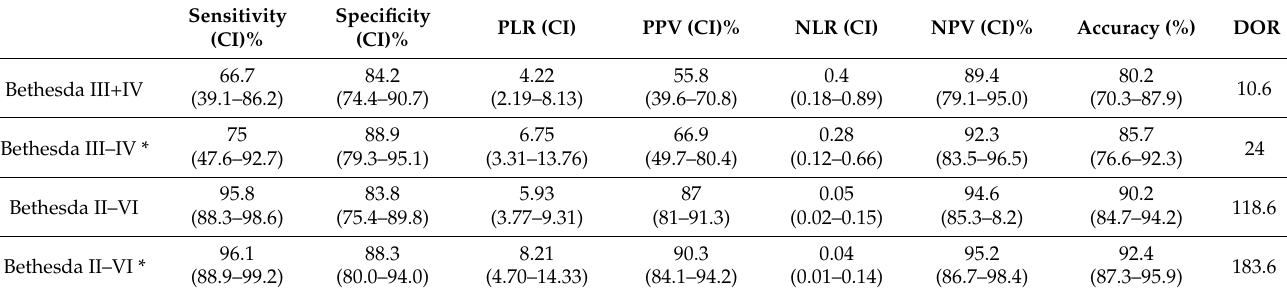
Table 3. Performance of all methods ACR TI-RADS, FNAC, and molecular testing in thyroid cancer detection. The data were calculated for all cytological cohorts and separately for the cohorts of categories Bethesda III and IV. Positive predictive value (PPV), positive likelihood ratio (PLR), negative predictive value (NPV), negative likelihood ratio (NLR), and diagnostic odds ratio (DOR). Bethesda III–IV * and Bethesda II–VI * were calculated after including positive molecular testing additionally confirmed in histology (not in